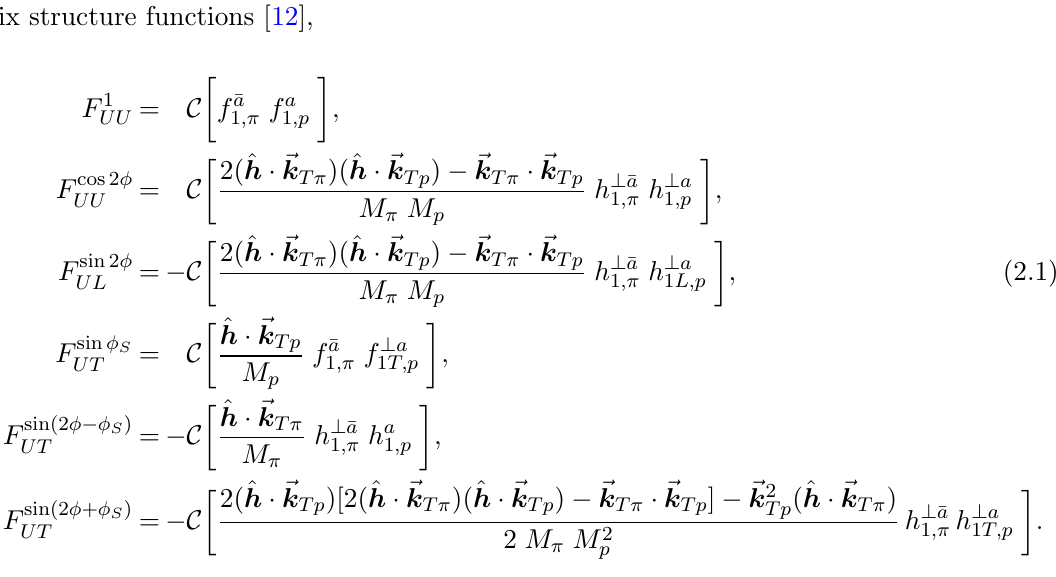
Figure 1 . The DY process in the Collins-Soper frame where the pion and the proton come in with di(cid:11)erent momenta P (cid:25) , P p , but each carries the same transverse momentum 1 lepton pair is at rest. The angle (cid:30) describes the inclination of the leptonic frame with respect to the hadronic plane, and (cid:30) S is the azimuthal angle of the transverse-spin vector of the